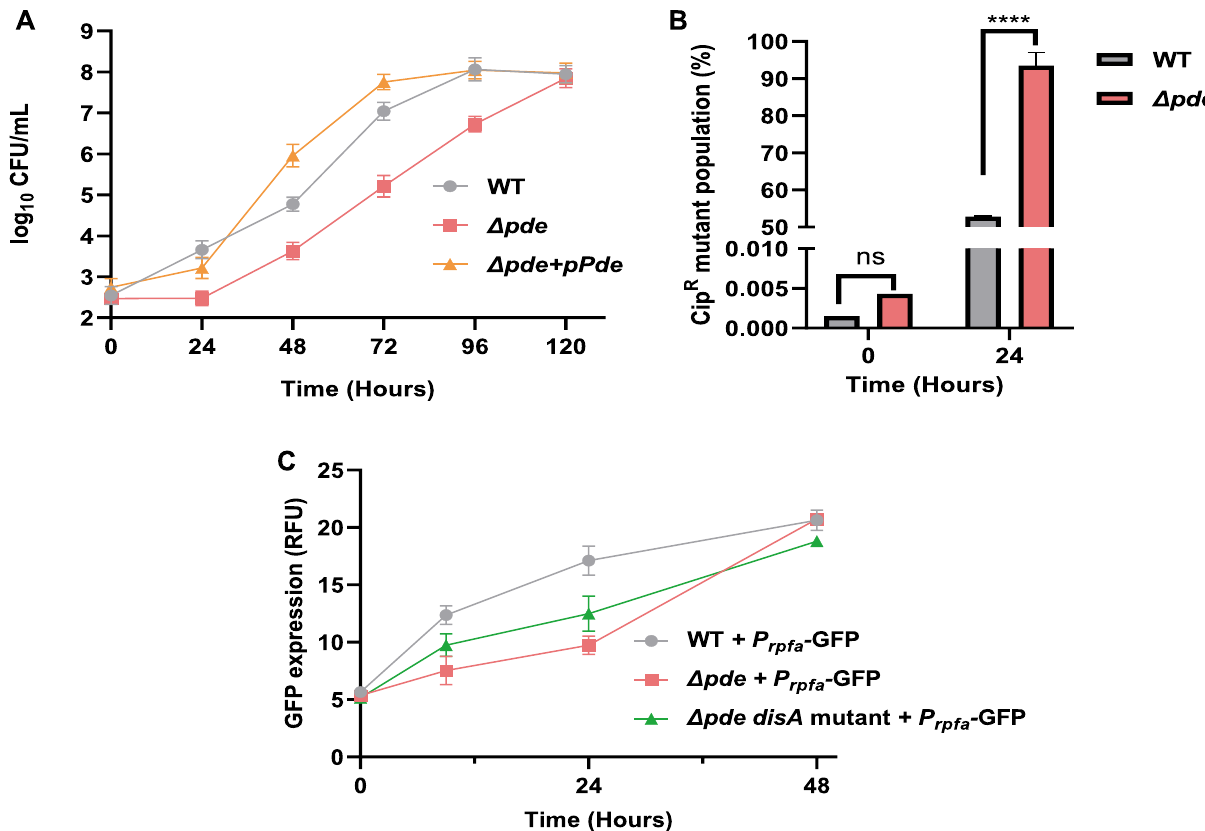
Figure 4. ( A ) Regrowth of persisters (after 10X ciprofloxacin treatment and subsequent washing of the drug) was significantly decelerated by high c-di-AMP concentration in Δpde strain, unlike WT and the complementation strain ( Δpde + pMV361- pde ) [N = 3]. ( B ) Slower resuscitation of Δpde surviving cells results from a rapid enrichment of genetic mutants, around 93% of mutant population enrichment happened in Δpde strain within 24 h of the killing, whereas in the case of WT strain ~ 52% of cells became ciprofloxacin mutants [N = 3]. ( C ) Significantly slower induction of the P rpfA (as a GFP readout) in Δpde background confirms the molecular basis of slower persisters regrowth [N = 3], when the c-di- AMP level was normalized in the same strain by a disA gene frameshift mutation, P rpfA induction was almost restored to the WT level. All the graphs are plotted using GraphPad Prism8, unpaired t-test was used to calculate statistical significance: ***P < 0.001; **P < 0.01; *P < 0.05; ns =